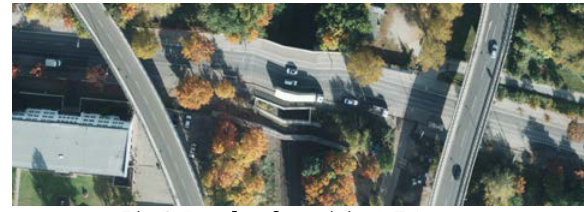
Fig. 8: Results of remaining DTM errors